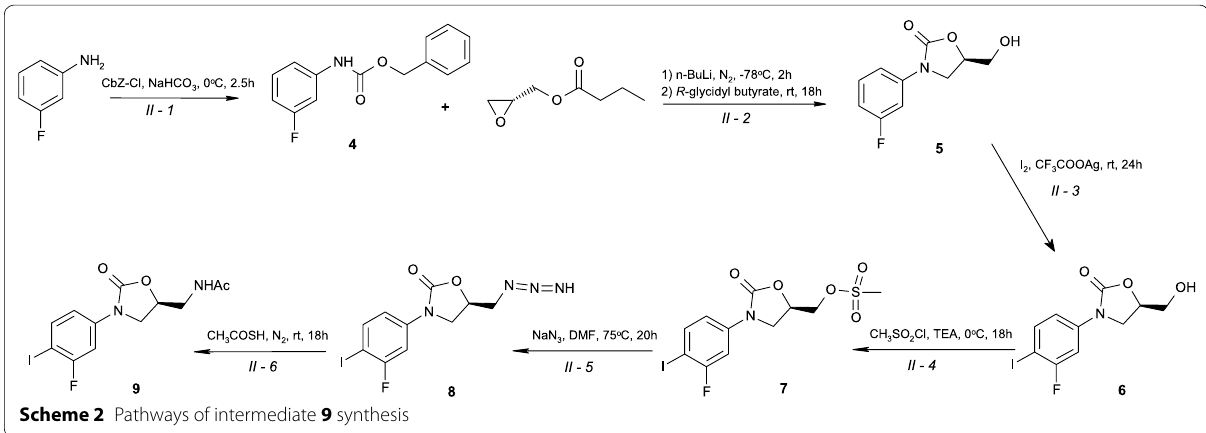
Scheme 2 Pathways of intermediate 9